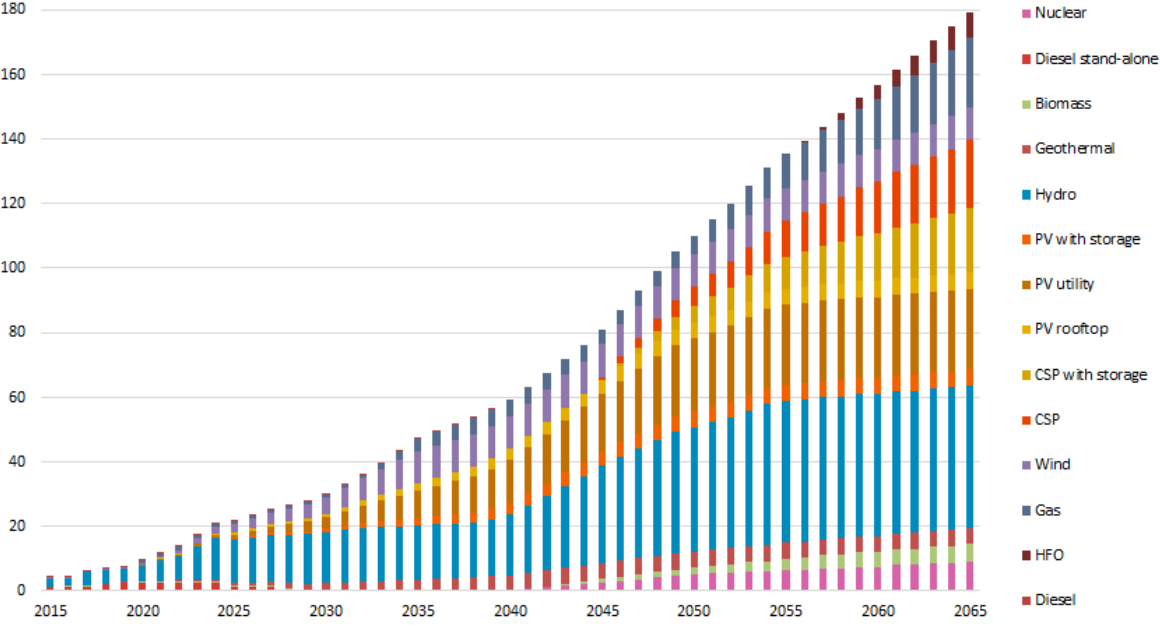
Figure 1. Power generation capacity of grid-connected technologies in the Drought Scenario.